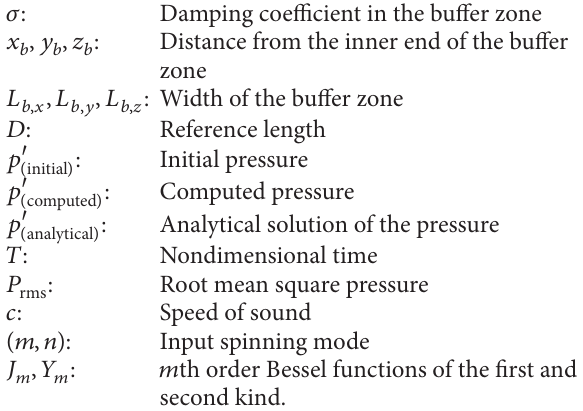
wing-body and the nacelle-pylon junctions, and the present solver demonstrated a robust treatment of these